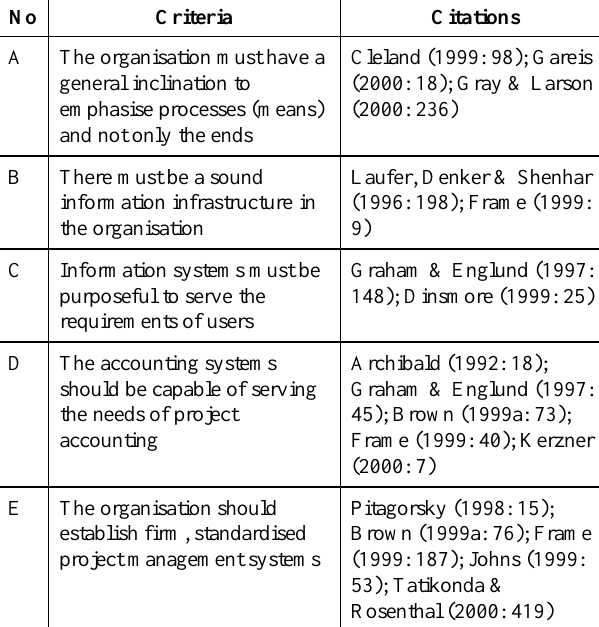
Table 5: The need for standardised systems and